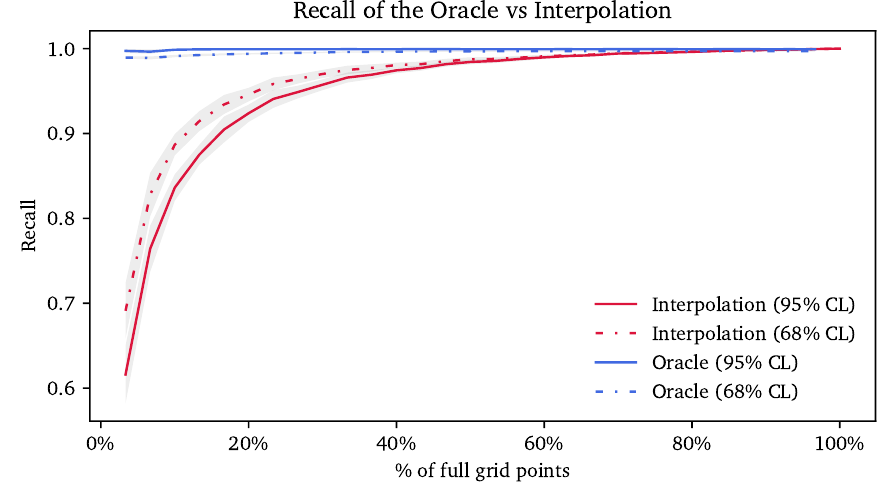
Figure 5: Recall of the C ONTUR O RACLE compared to the recall of a simple linear inter- polation from a random sample of the same number of points, for the 95% and 68% CL contour of the 2HDM + a model. The O RACLE achieves immediate near-perfect re- call, while almost 80% of the parameter points are required for equivalent interpolation results. The grey clouds represent the standard deviation of the 30